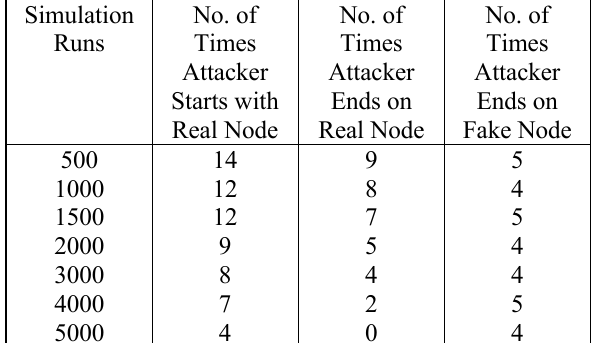
Table 5. Performance evaluation table for real to real and